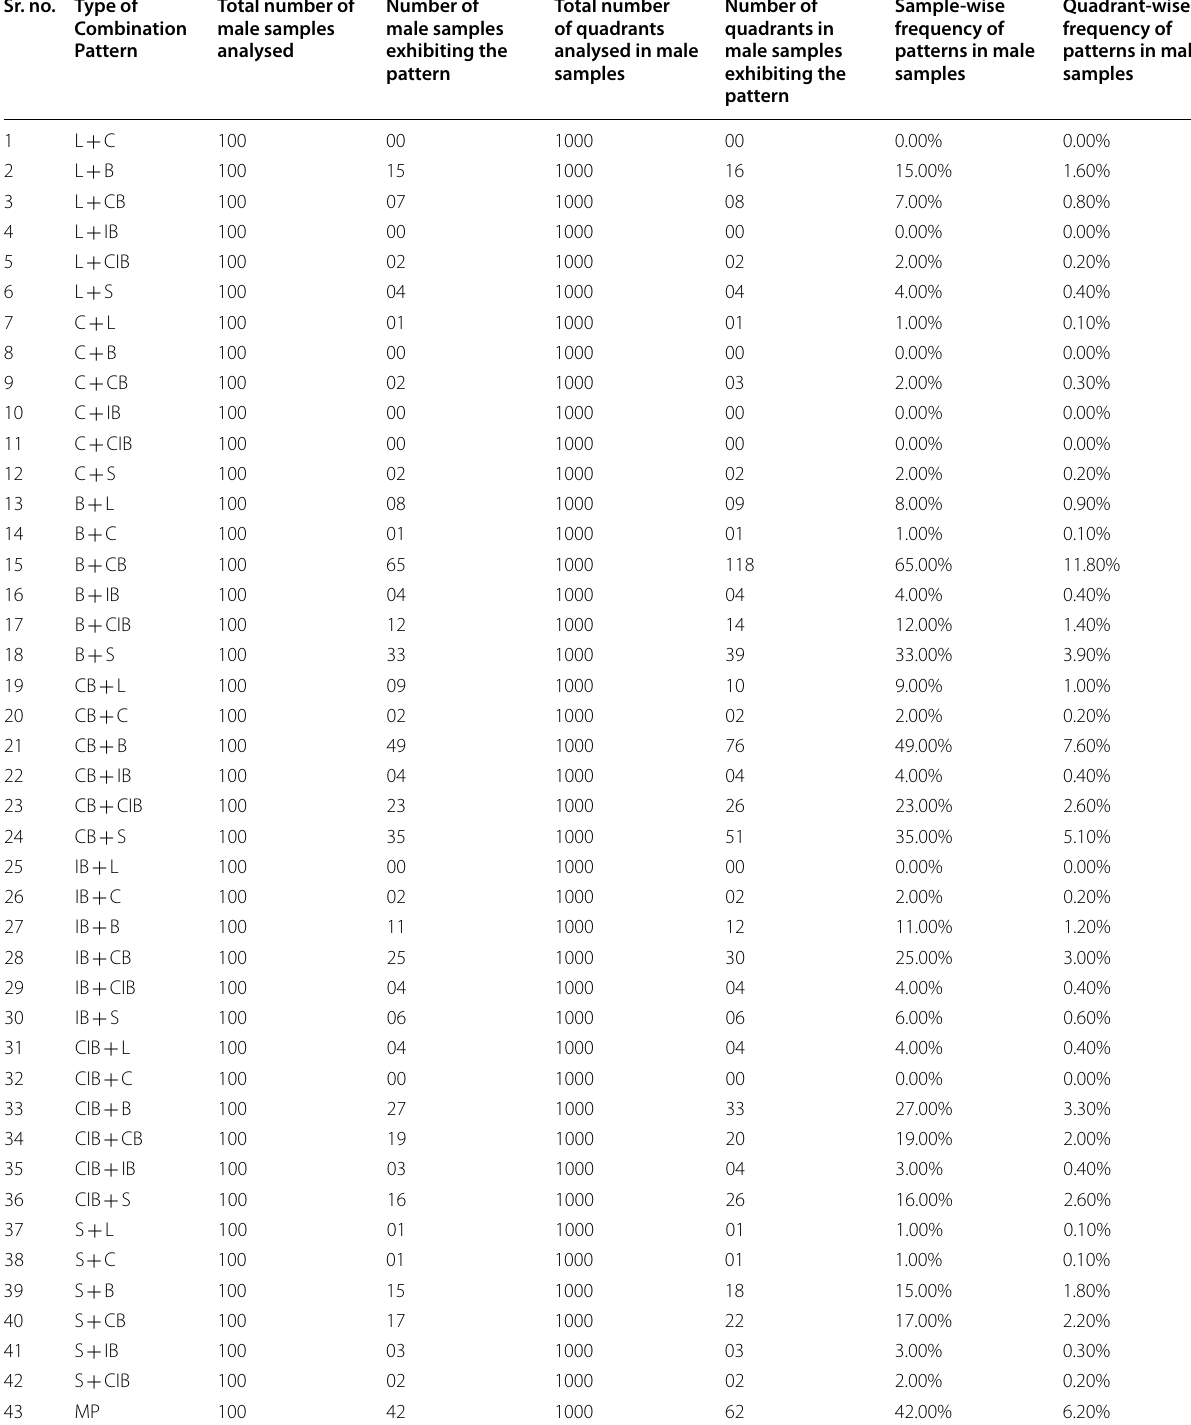
Table 9 Frequency of Combination Patterns in male